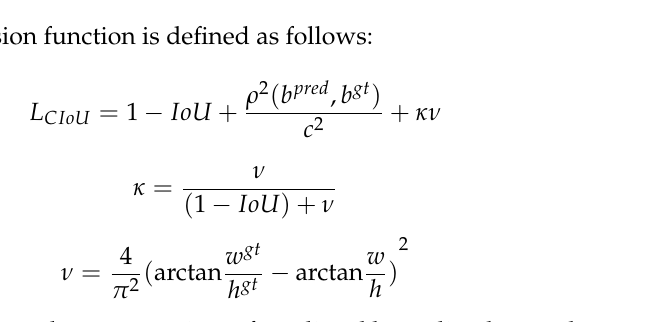
Figure 4. Illustrations of complete-intersection over union (CIoU) loss for bounding box regression. c is the diagonal length of the smallest enclosing box covering bbox1 and bbox2, and d is distance of center-points of two boxes. Besides, additional is the parameter of aspect ratio.